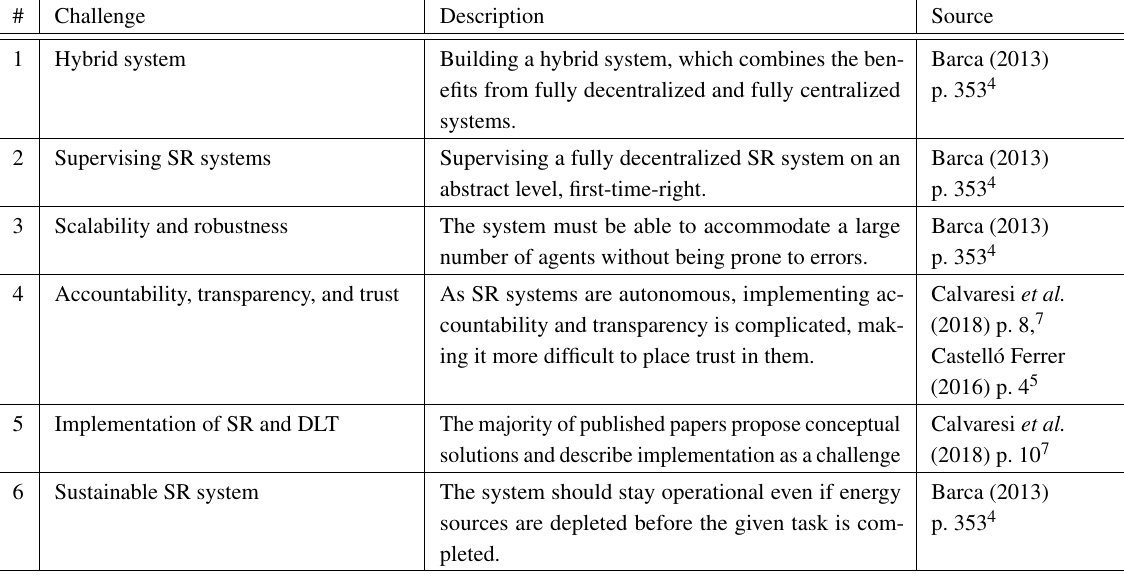
Table 1. A series of challenges that impede widespread adoption of SR for real-world